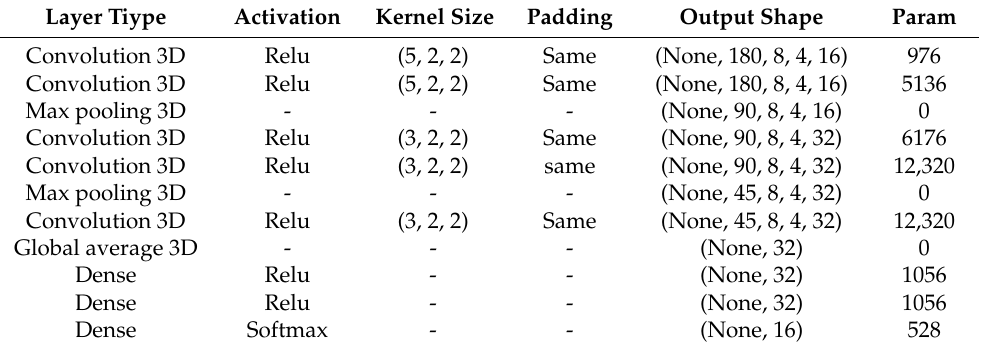
Table 7. Hyper parameters of 3-dimension CNN.